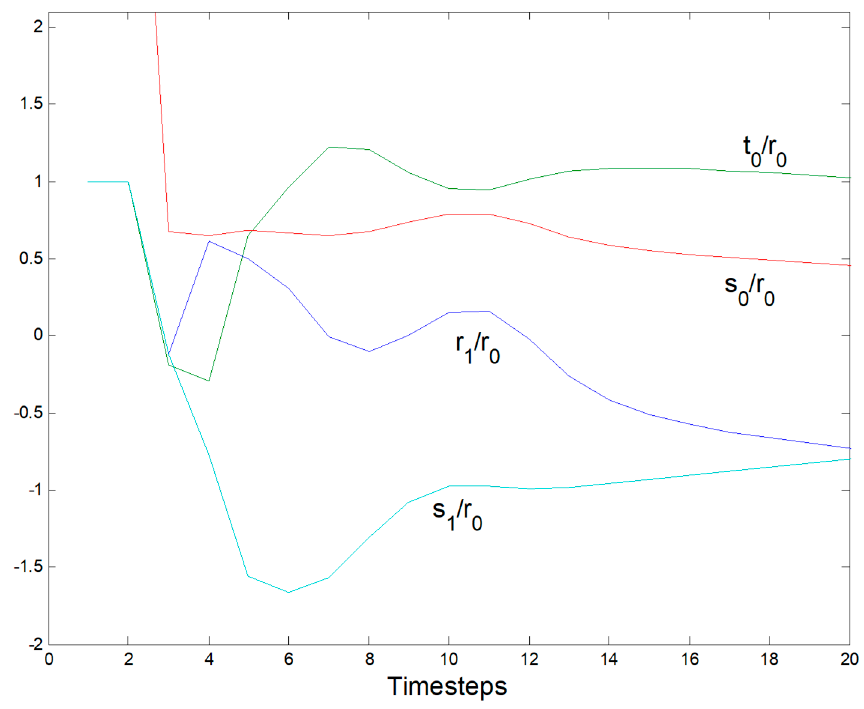
Figure 11 . Normalized parameter estimates: Notice how quickly estimates converge.